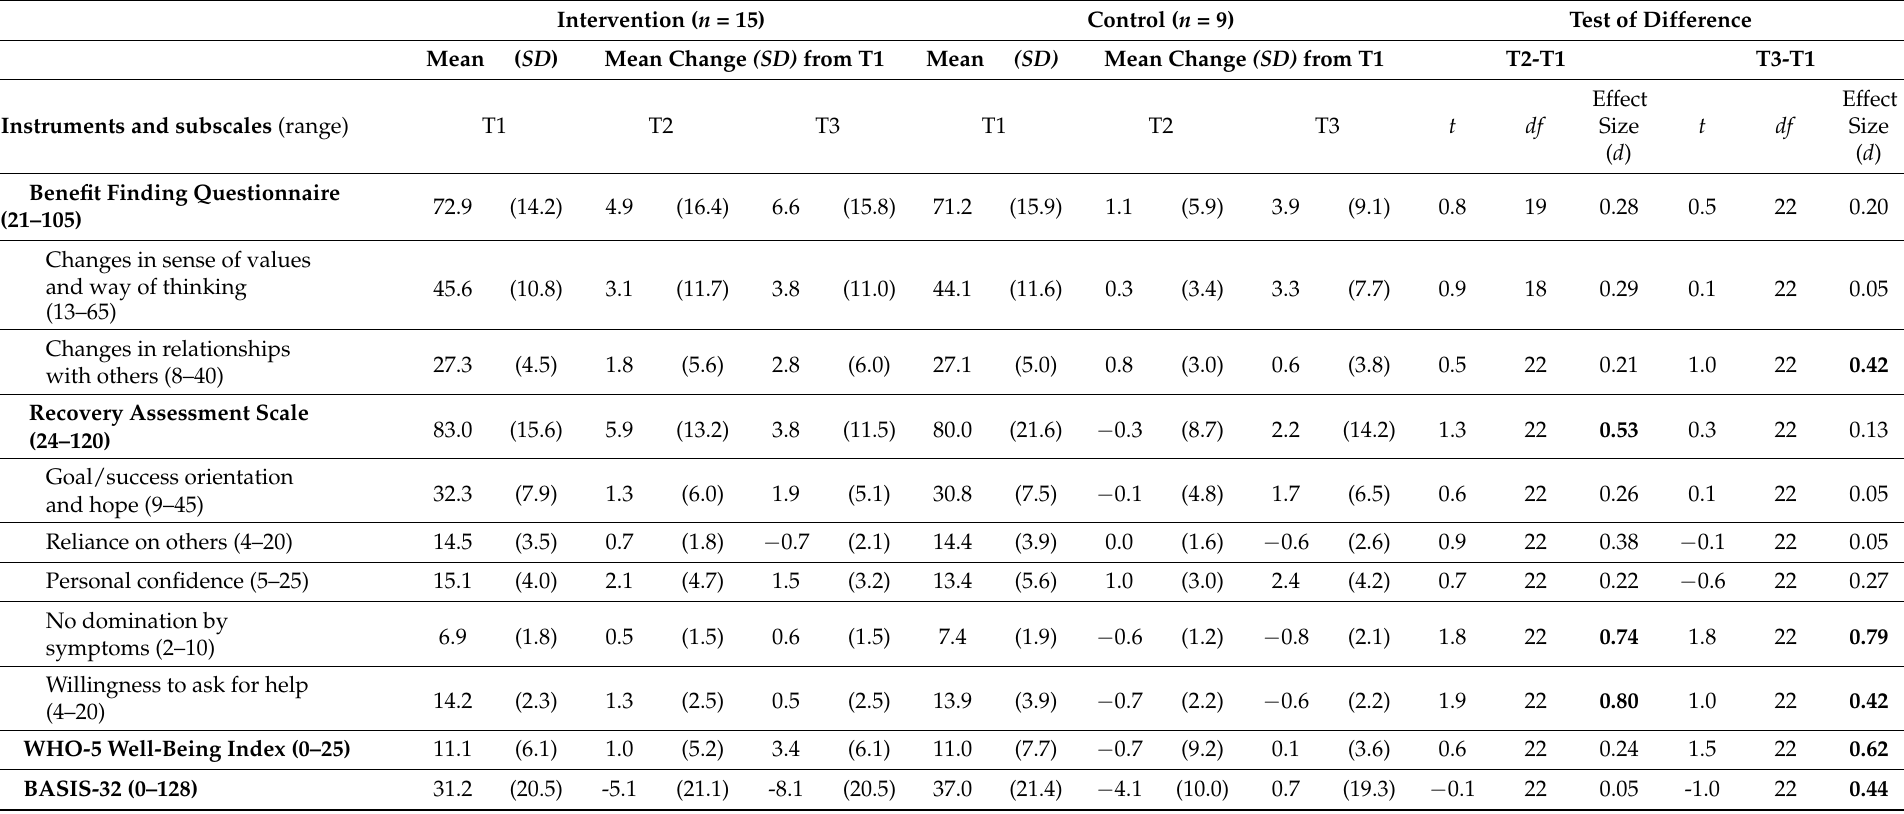
Table 2. The changes of the scores in each scale from baseline to 3-month follow up, with differences within groups over time ( n =